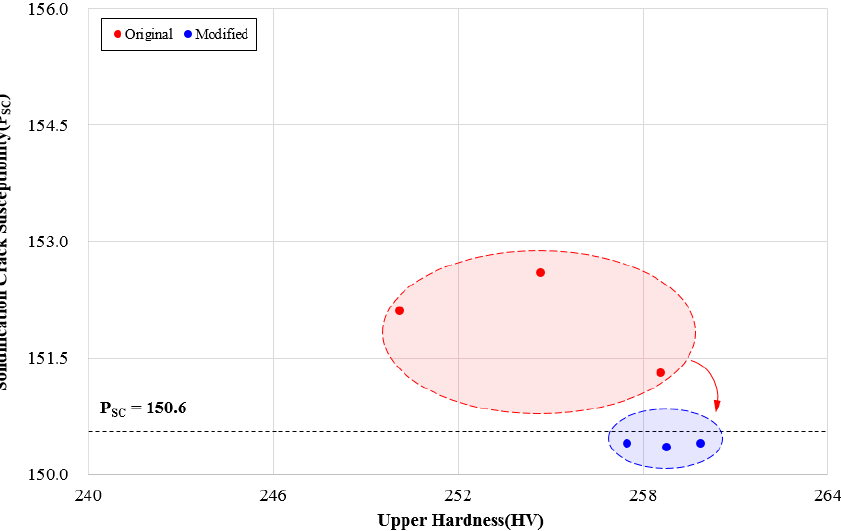
Figure 12. Crack susceptibility distributions using modified input parameters.